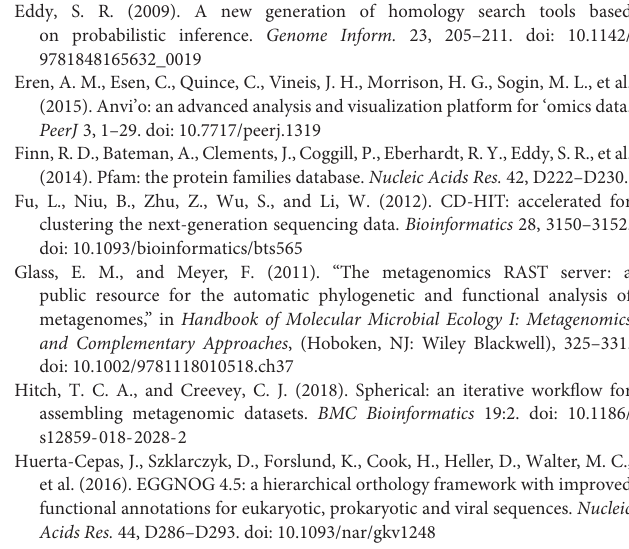
FIGURE S1 | The presence of several carbohydrate degradation pathways in the bins. The outer circles indicate the percentage of genes from a pathway present in each of the bins. According to that gene profile, MinPath estimates whether or not the pathway is present. Only pathways inferred to be present are colored. As in Figure 4 , the bins tree is performed from a distance matrix of the orthologous genes’ amino acid identity, using the compareM software (https://github.com/dparks1134/CompareM). The four most abundant phyla are colored (branches in the tree), as well as the most abundant genera (bin labels). The picture was elaborated using the iTOL software